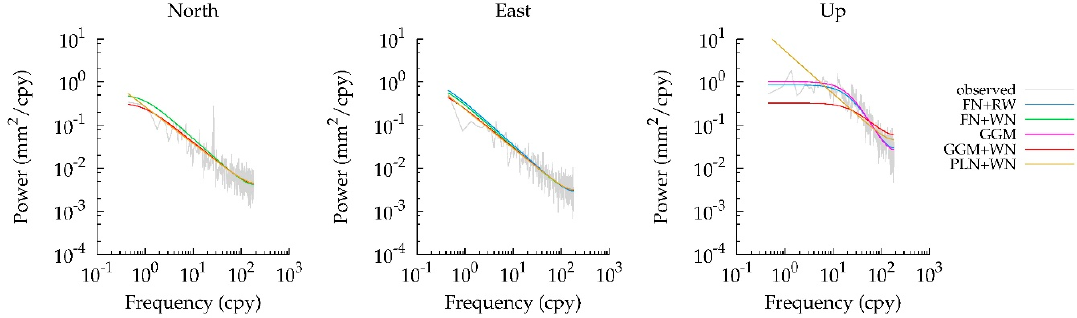
Figure 5. Power spectral densities of the time-series residuals of station TOIL based on the solution GOA_2.